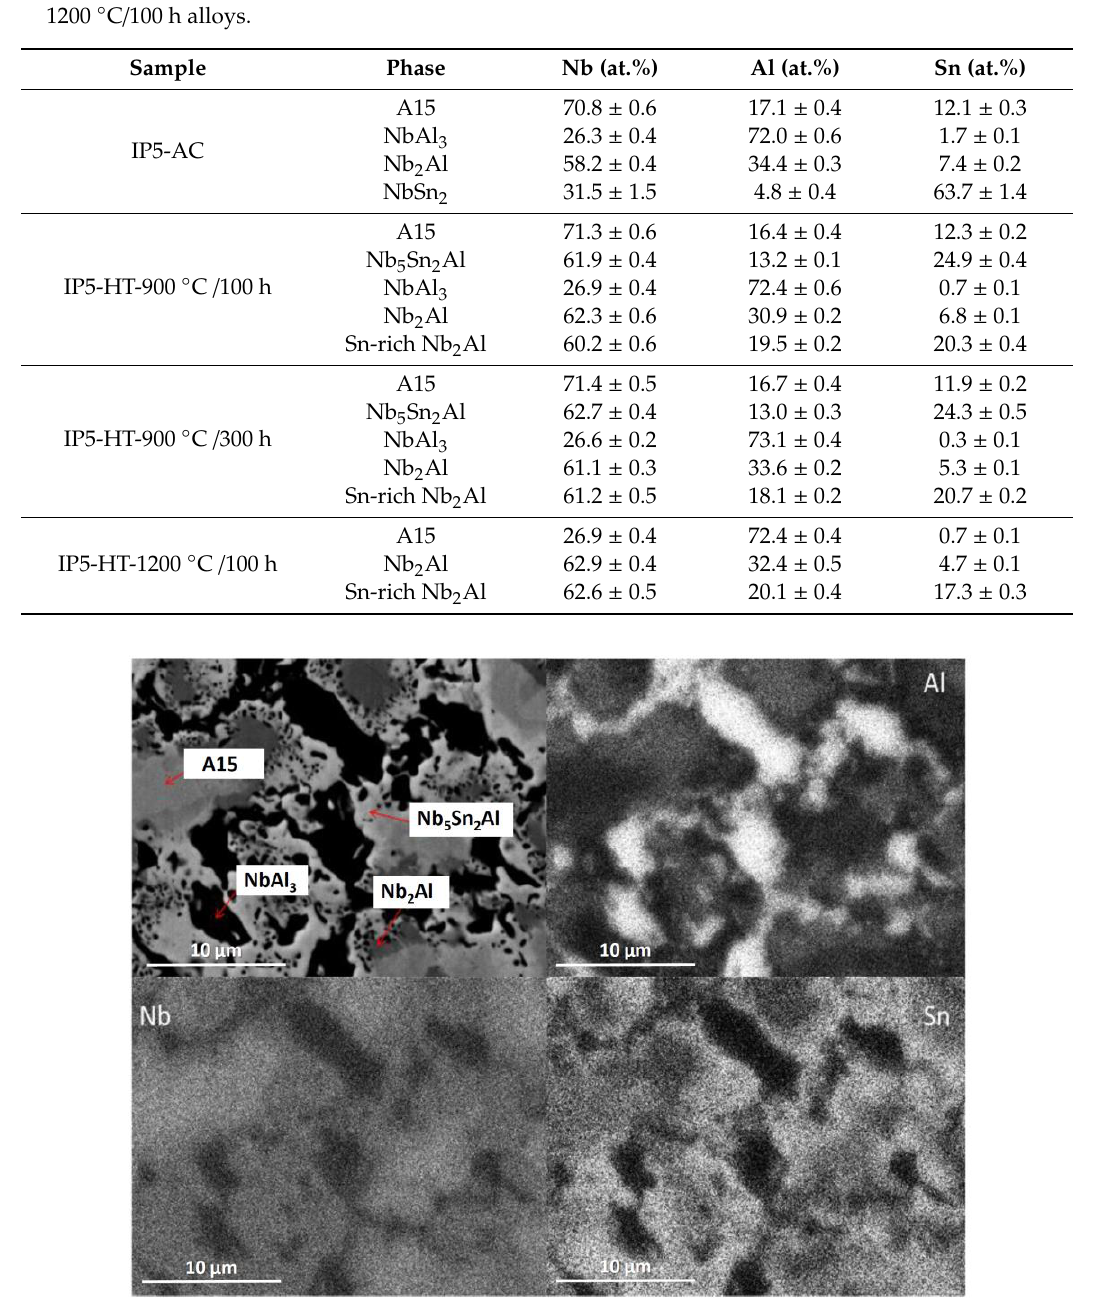
Figure 6. BSE image and X-ray element maps of IP5-HT 900 °C/100